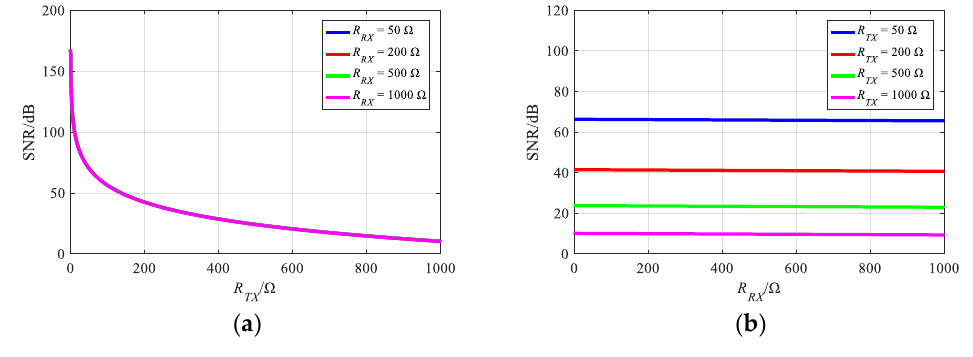
Figure 11. SNR versus ( a ) R TX ; ( b ) R RX .